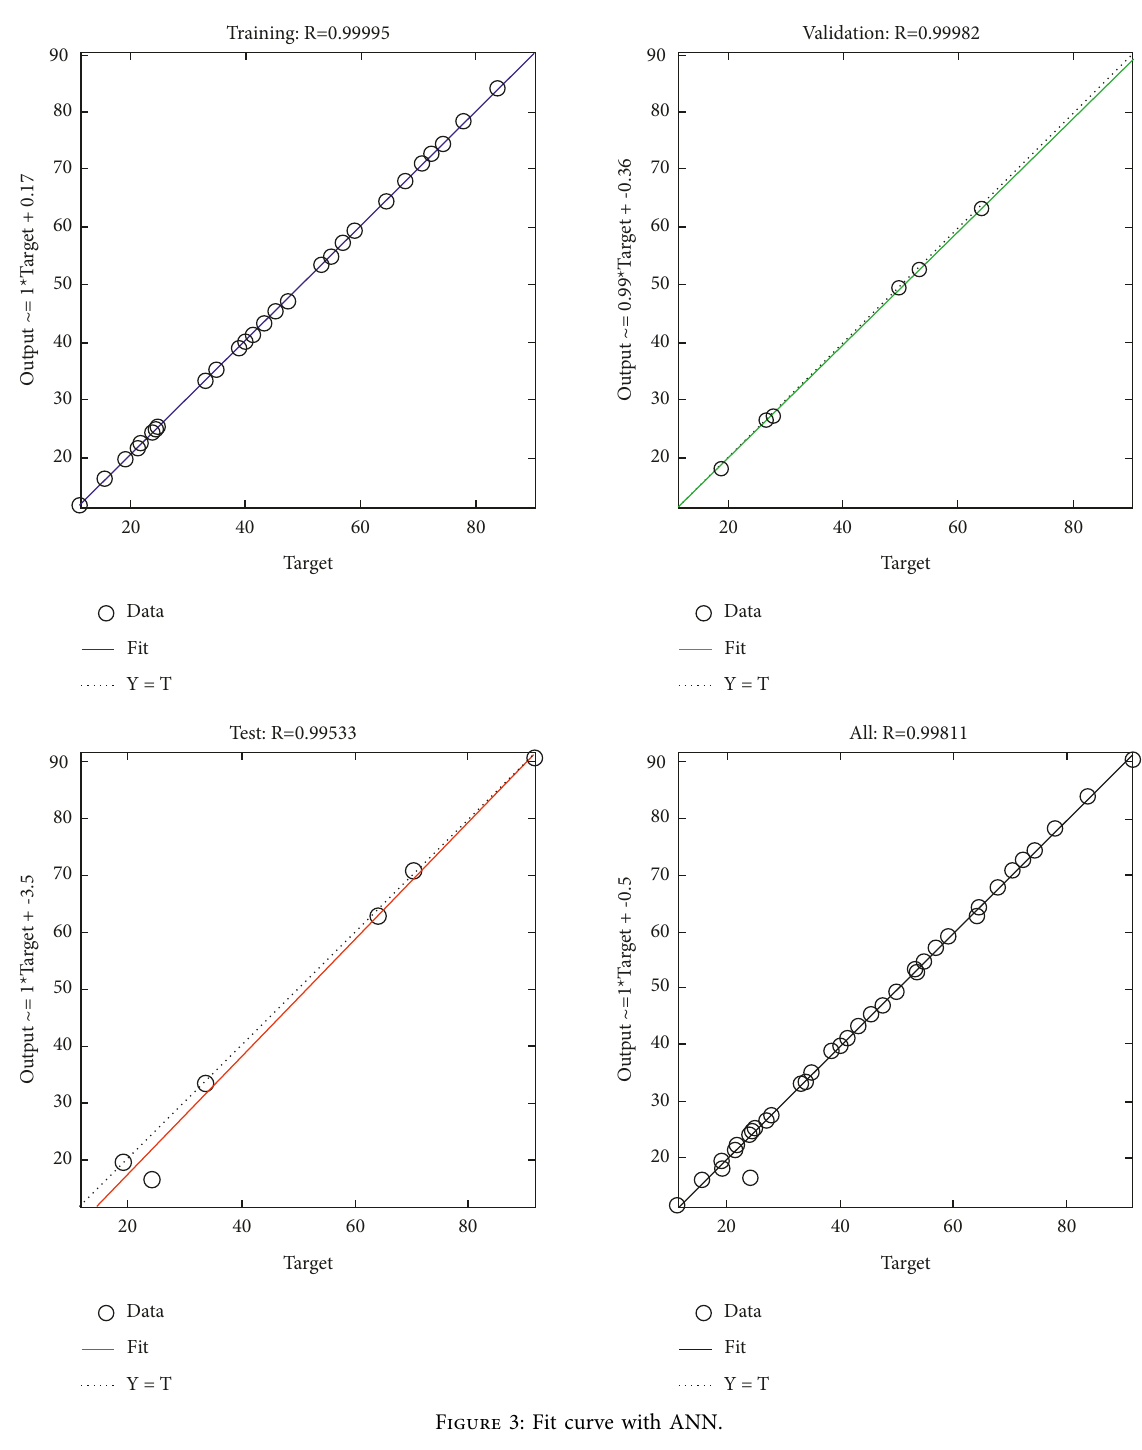
Figure 3: Fit curve with